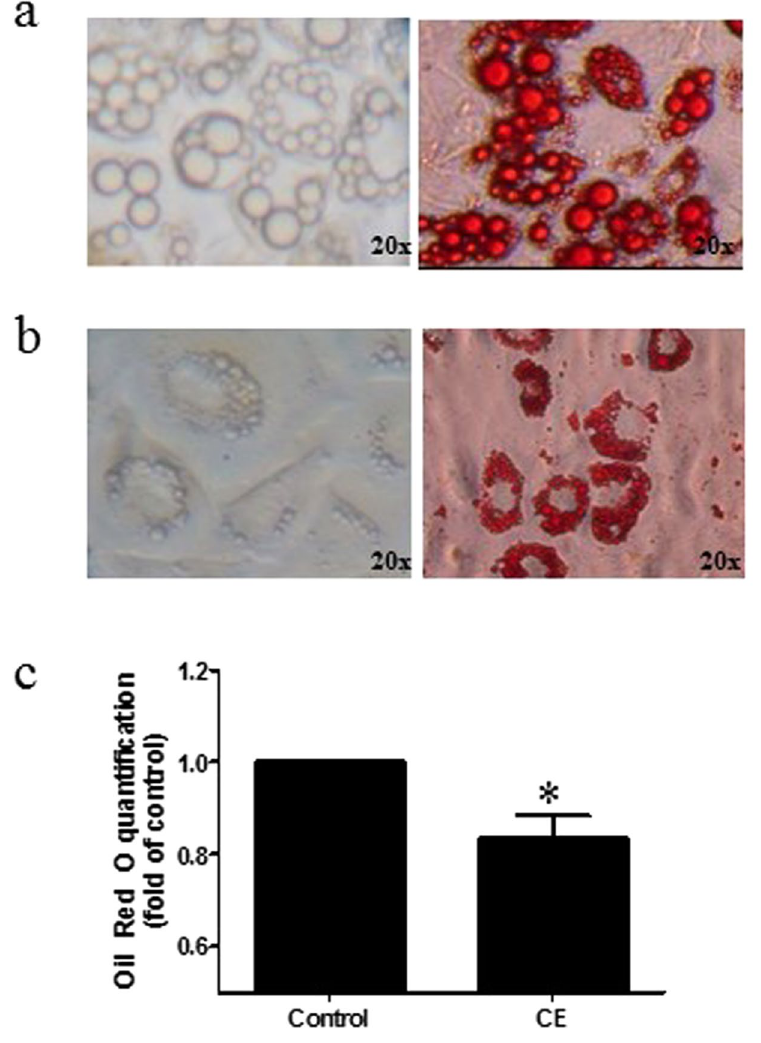
Figure 2. Oil Red O staining of ( a ) 3T3-L1 adipocytes and ( b ) CE-treated 3T3-L1 adipocytes. ( c ) Lipid levels in control and CE-treated 3T3-L1 adipocytes. CE, cinnamon extract (80 µ g/ml). Original magnification 20x. * p < 0.05, n = 3 individual